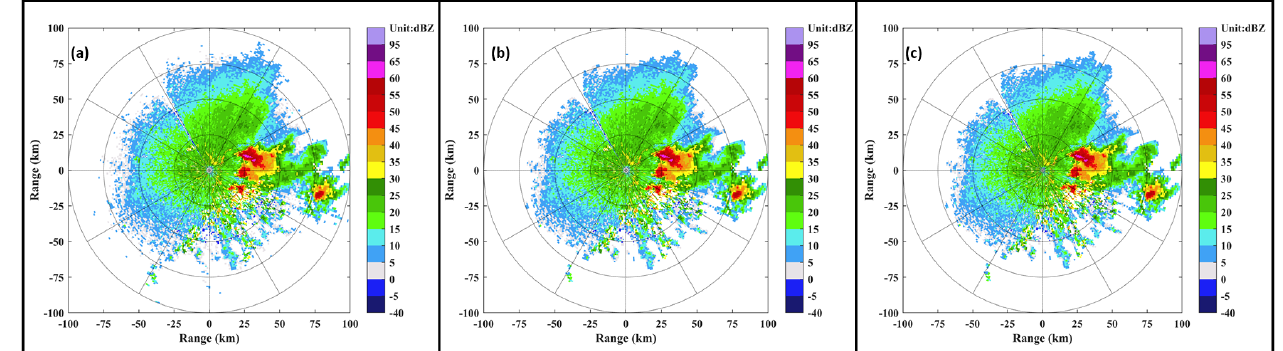
Figure 10 Figure 10. Reflectivity quality control results at 0.5 ◦ . ( a ) Original data, ( b ) removed isolated points, and ( c ) quadratic Fourier interpolation.